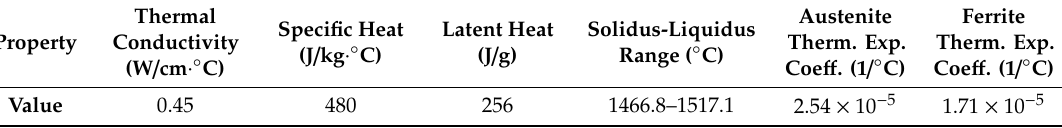
Table 2. Thermal properties of low-carbon constructional steel S235JR.